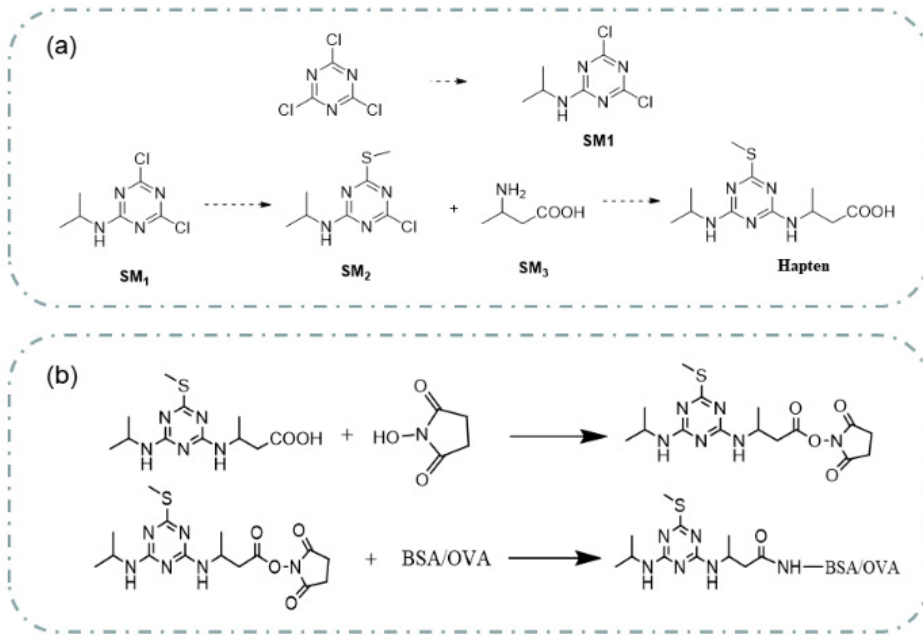
Figure 1. The synthesis route of prometryn hapten ( a ), immunogen and coating antigen ( b ).